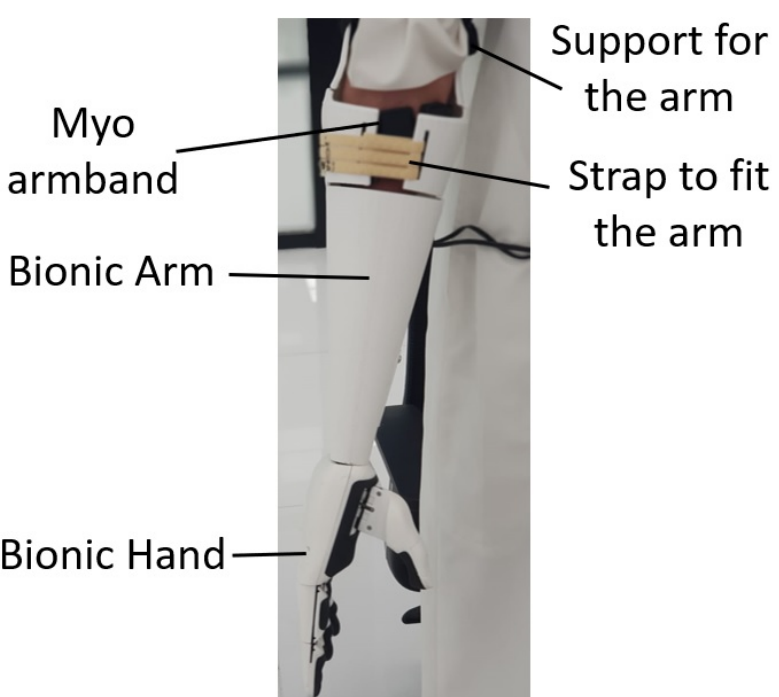
Figure 6. Amputee wearing the bionic